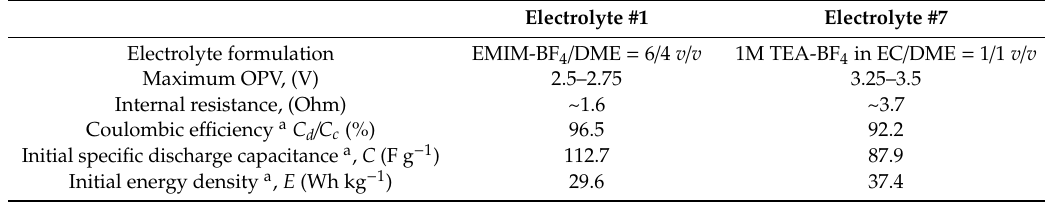
Table 12. Summary of the electrochemical properties of the EDLC cells with IL-based